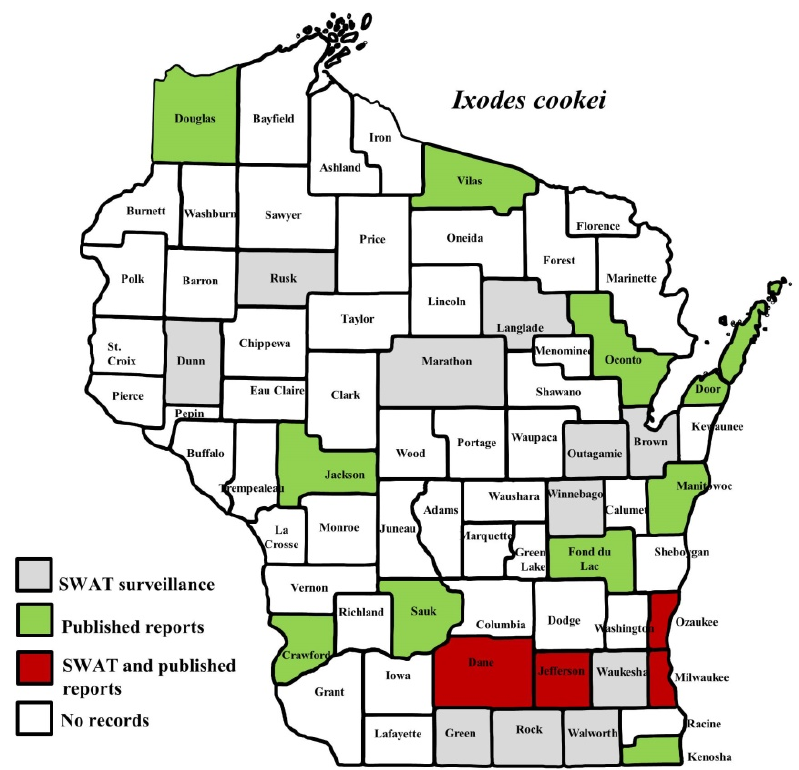
Figure 4. County records for Ixodes cookei in Wisconsin [18,27].